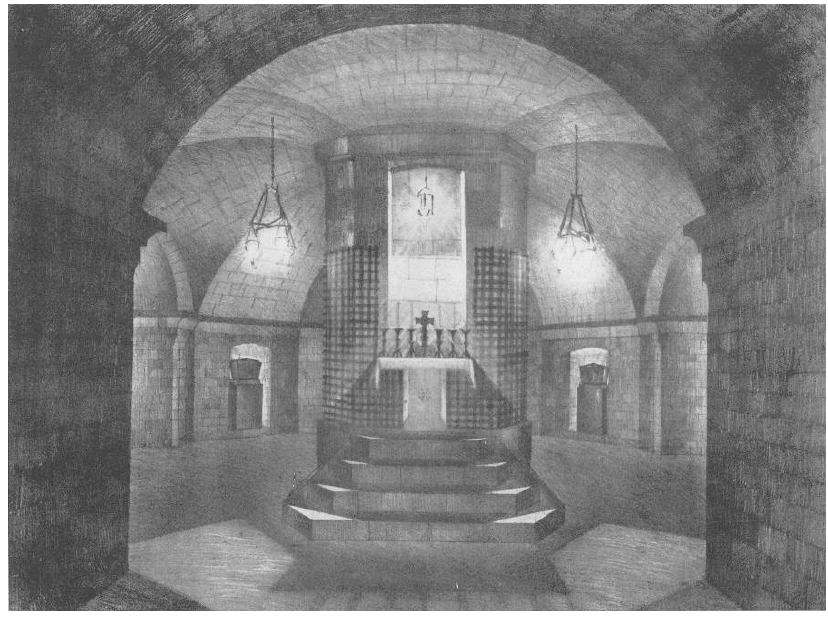
Figure 4. Ugo Tarchi, Tomba del Santo nella Basilica di San Francesco ad Assisi, perspective, 1940.